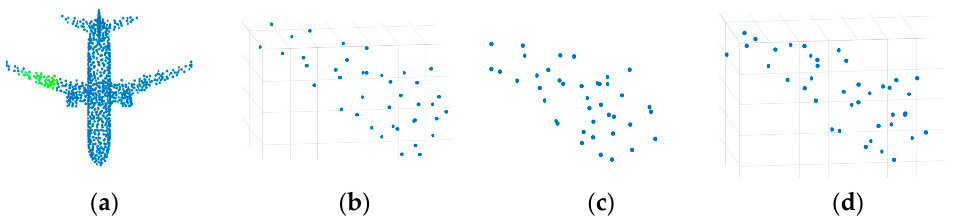
Figure 8. Compression and reconstruction of point cloud by using autoencoder with L2 loss function. ( a ) 3D point cloud. ( b ) 3D points at the green area of ( a ). ( c ) Compressed result of ( b ). ( d ) 3D points reconstructed from ( c ).